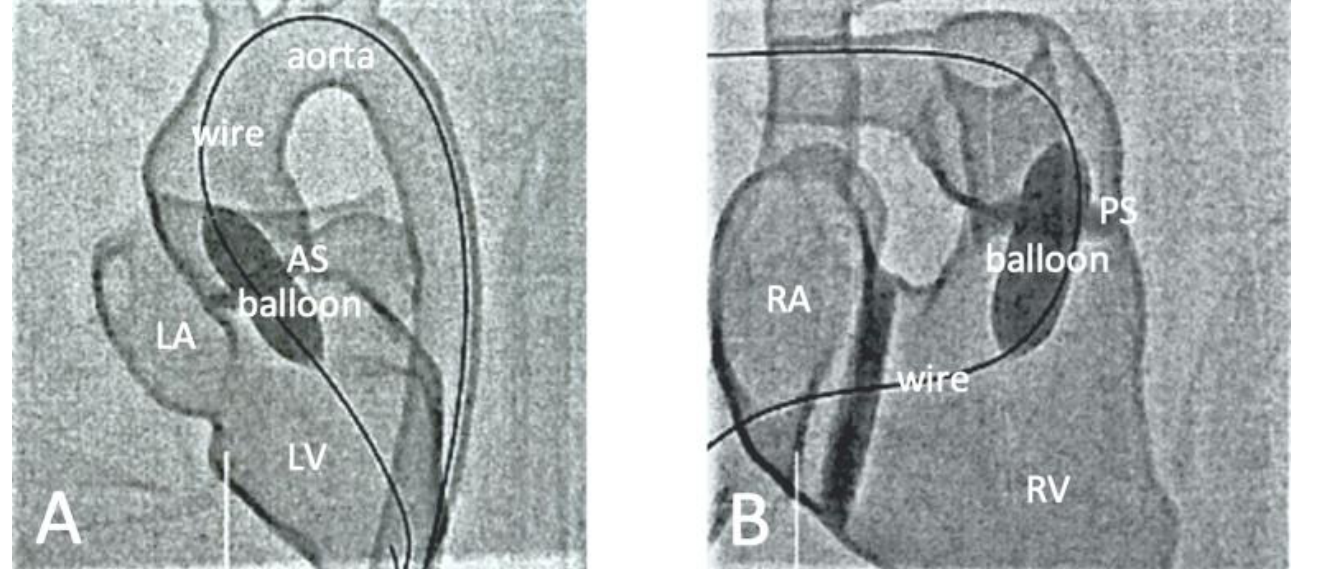
Figure 12. Fluoroscopic visualization of balloon dilatation of valvular stenosis with use of a 3D- printed heart model. ( A ) Balloon dilatation for treatment of a valvular aortic stenosis (AS). ( B ) Balloon dilatation for treatment of a valvular pulmonary stenosis (PS). Reprinted with permission under the open access from Brunner et al. [87].